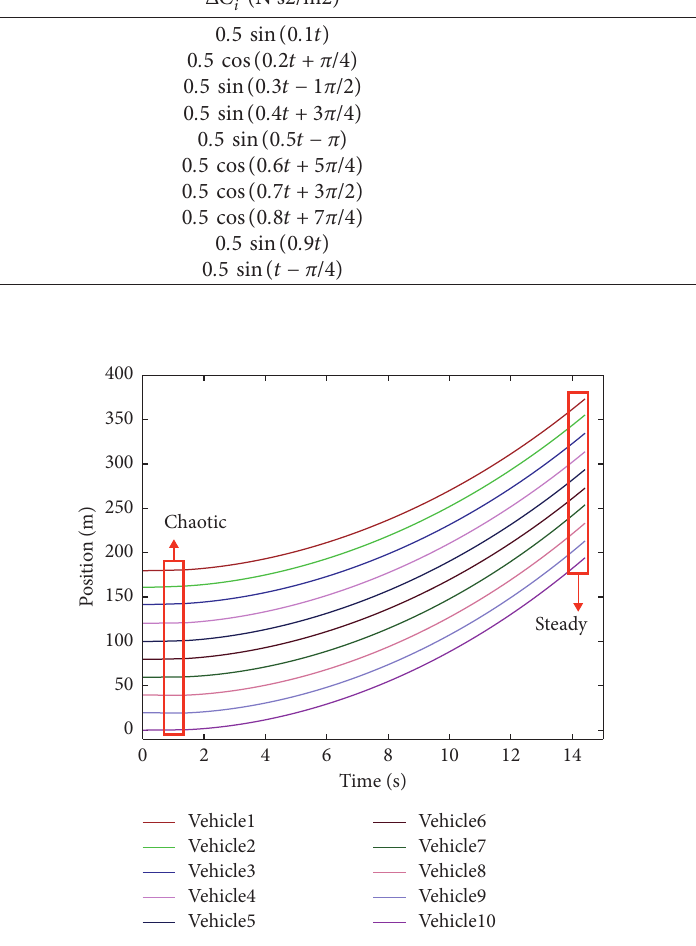
Figure 7: Position history under proposed controller (41).